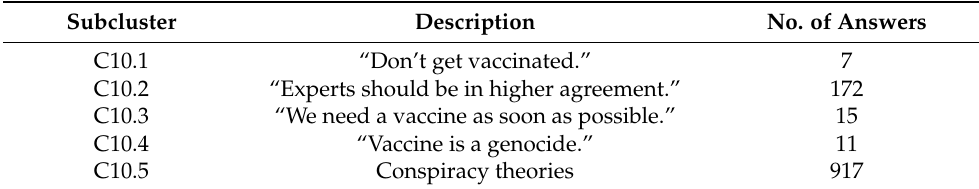
Table 6. Detailed analysis of cluster C10. It contains roughly five subclusters, but it is fairly diverse. It contains both respondents that wish to get vaccinated quickly (C10.3) and those that believe the vaccine is a Big Pharma scam